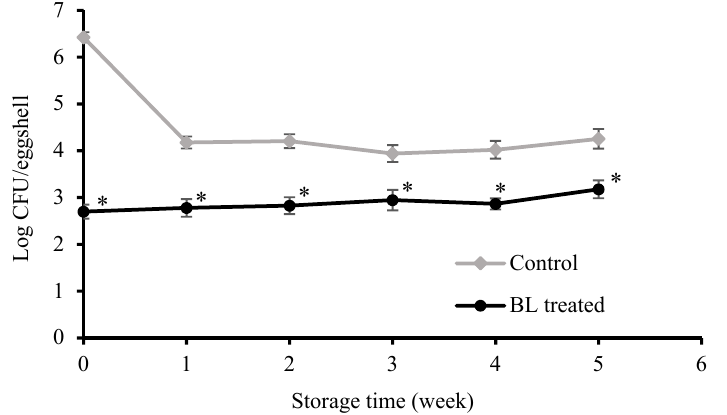
Figure 3. Inactivation of S . Enteritidis on polluted eggshells and microorganism count on eggshells after storage for 5 weeks. Asterisk (*) indicates significant ( p < 0.05) difference between BL-treated and control. Error bars represent the standard deviation of three separate experiments.